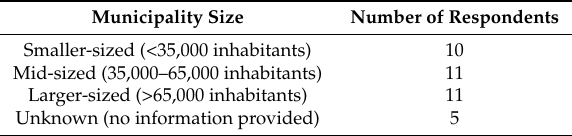
Table 1. Selection of respondents in municipalities of different